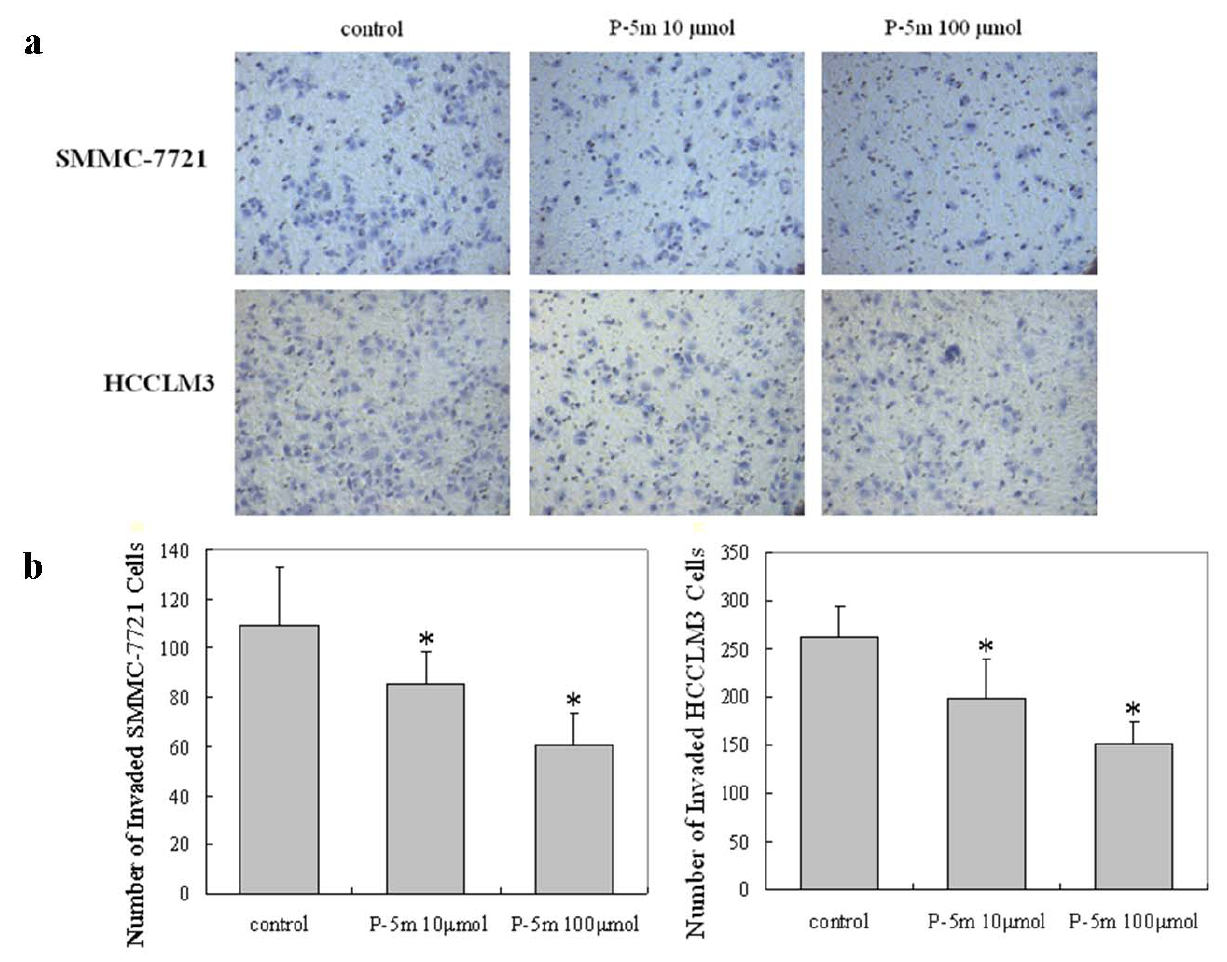
Figure 3. Effects of P-5m on cell invasion by SMMC-7721 and HCCLM3 cells. ( a ) SMMC-7721 or HCCLM3 cells were treated with various concentrations of P-5m (0, 10 and 100 μ mol) for 48 h. Cells in the lower chamber were then stained and quantified. ( b ) For each plate, a representative number of invaded cells were counted under the microscope and averaged in five random fields at ×400 magnification. Bars represent mean ± SD of these averages from triplicate plates. * P < 0.05, compared with the